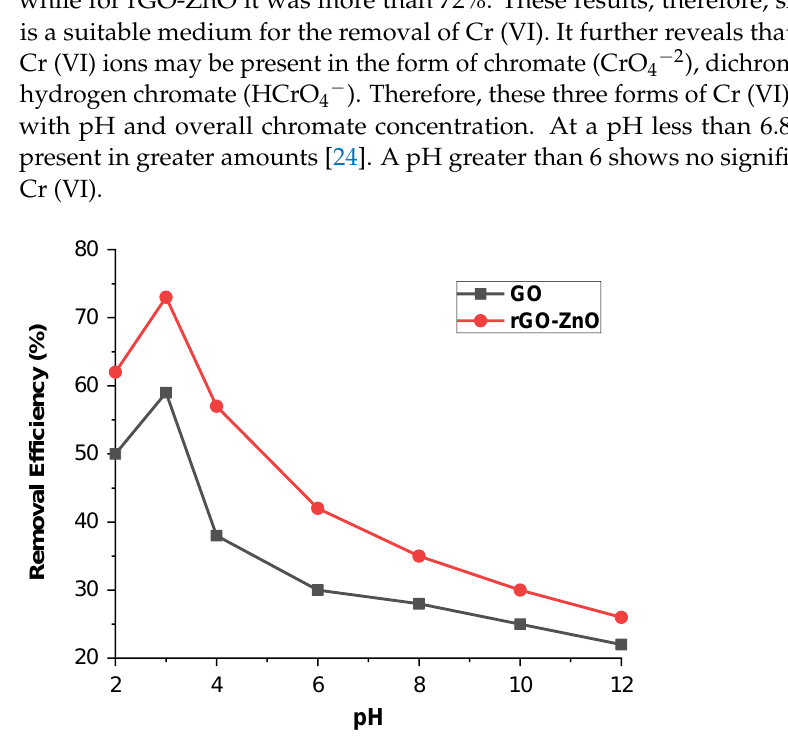
Figure 6. pH effect on % removal of Cr (VI) by synthesized adsorbents.